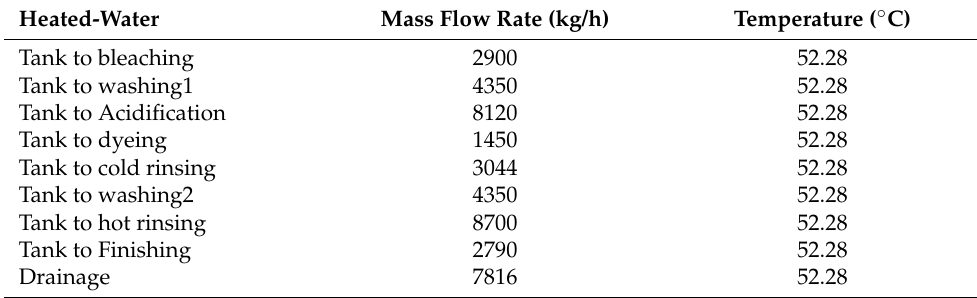
Table 8. Flow rate and temperature of the heated-water (Case